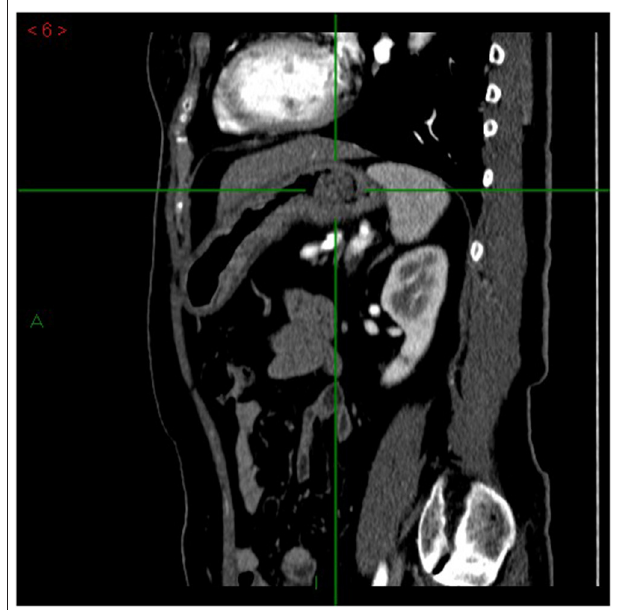
FIGURE 1 | Multidetector computed tomography (MDCT) arterial-phase, sagittal plane. Focal mass in the gastric lumen, next to the cardias, characterized by enhancement comparable to that of the gastric wall. The mass is vegetating into the gastric